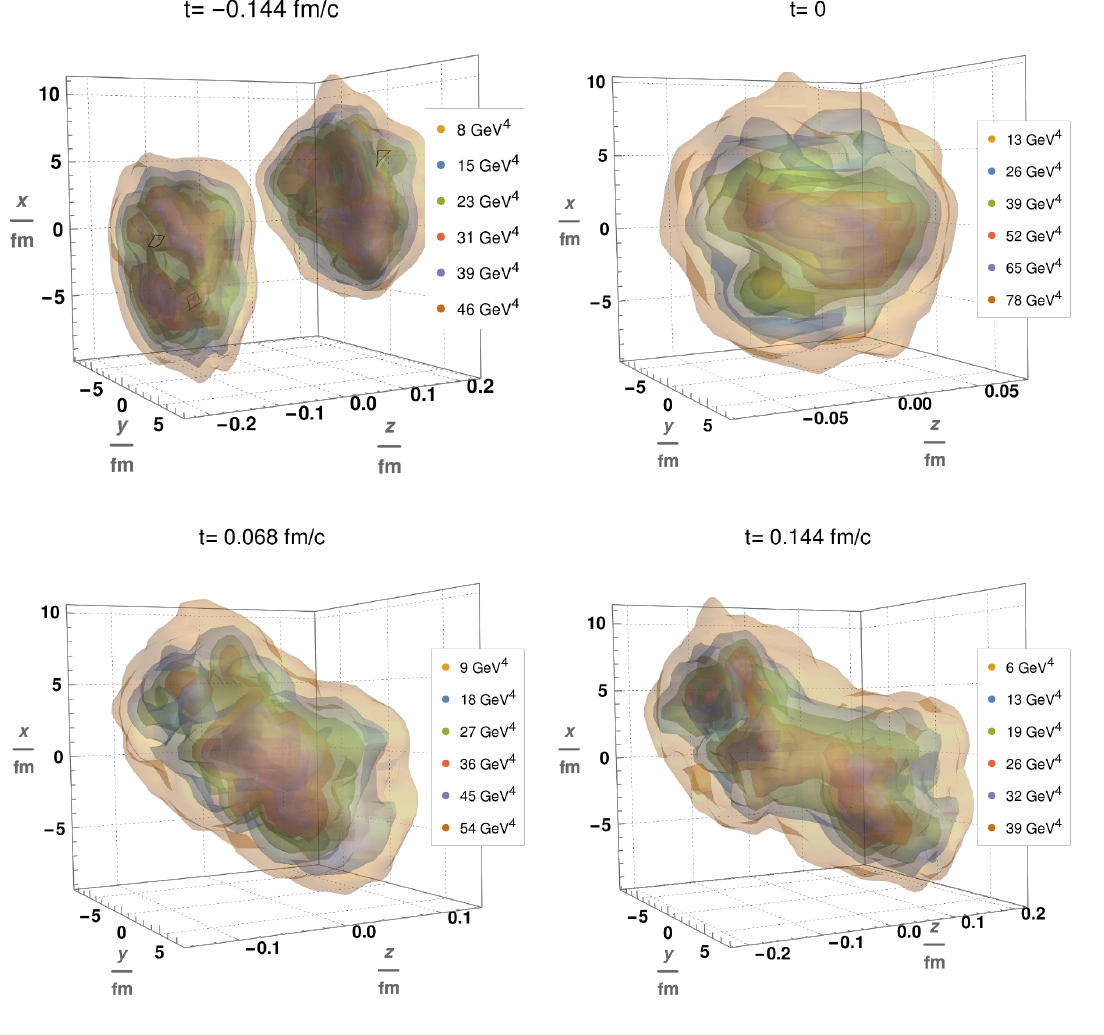
Figure 1 . The energy density distribution during the collision of localized, granular, highly con- tracted holographic shocks computed up to first order in transverse derivatives. The spatial direc- tions are labeled in units of [fm]. From top left to bottom right: the surface plots of the energy density evaluated at times t = − 0 . 144 fm/ c , t = 0 fm/ c , t = 0 . 068 fm/ c , and t = 0 . 144 fm/ c